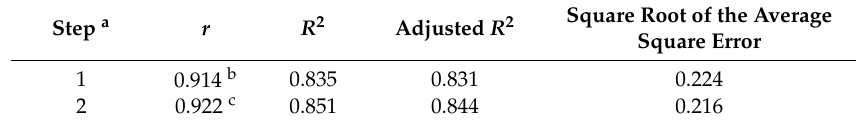
Table 5. Summary of Model 4 to estimate the compressive strength of aerogel-based mortars.